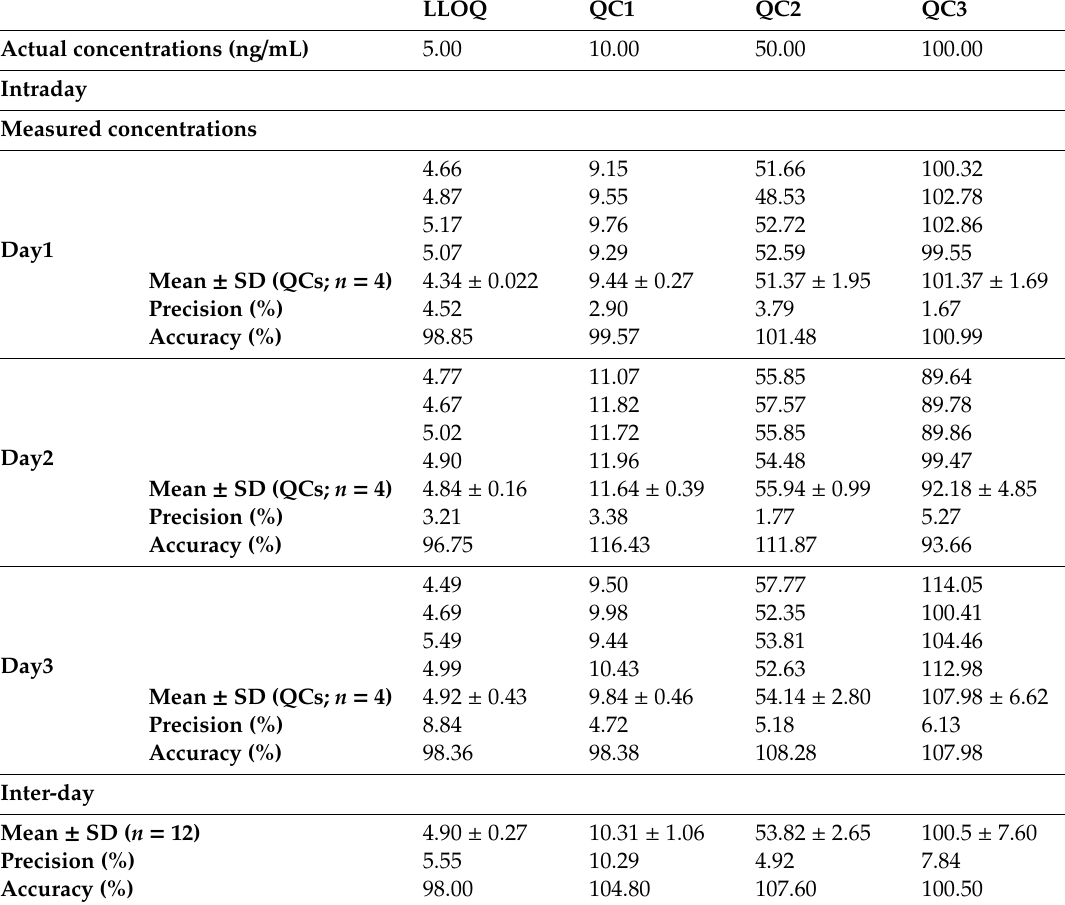
Table 2. Intra- and inter-day validation of the method for quantitative determination of PTX.